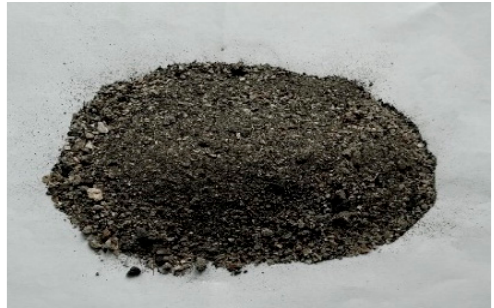
Figure 2. Co- fi red ash—Agro-industrial waste. Figure 2. Co-fired ash—Agro-industrial